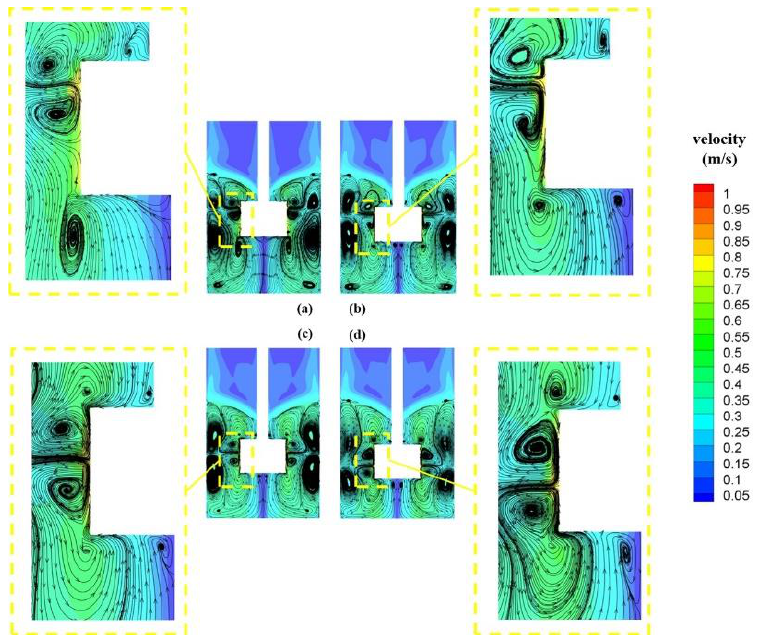
Figure 6. The streamlines of the central vertical cross-section at an immersion depth of ( a ) 100 mm, ( b ) 110 mm, ( c ) 120 mm, and ( d ) 130 mm. ( b ) 110 mm, ( c ) 120 mm, and ( d ) 130